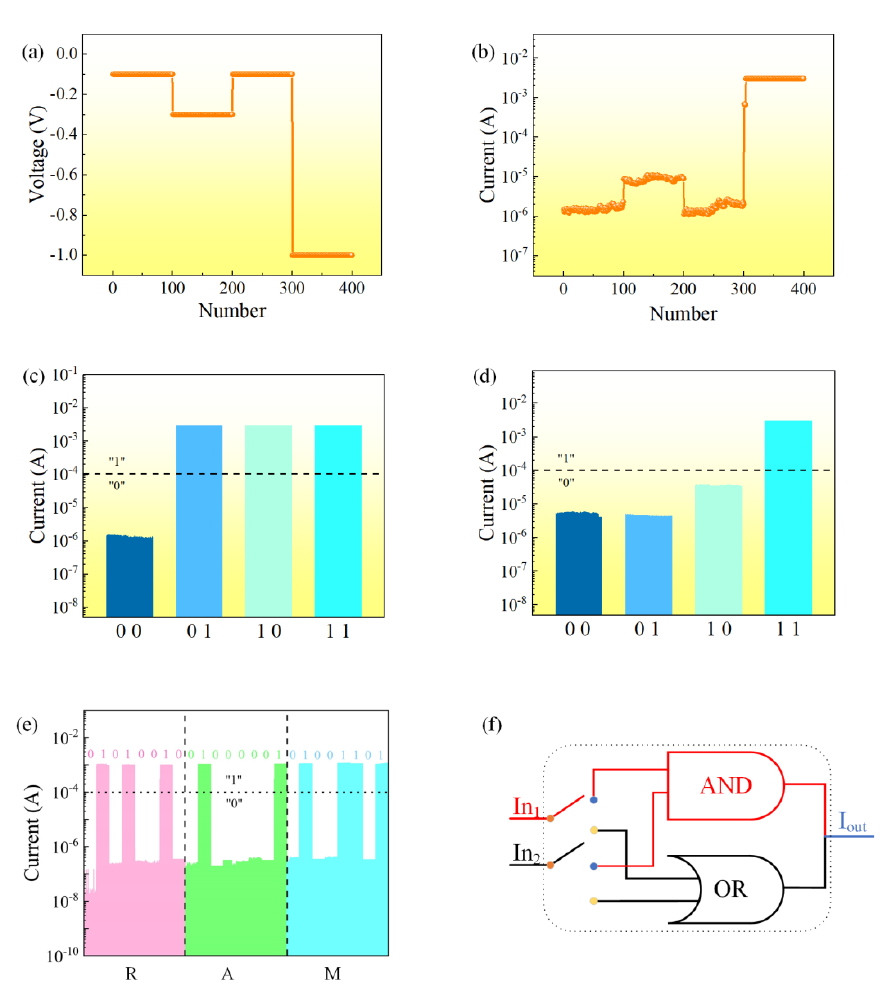
Figure 6. Al/EA:Ag + /ITO device: ( a ) input voltage and ( b ) current response. ( c ) Logic “OR gate”. ( d ) Logic “AND gate”. ( e ) Character display. ( f ) Working principle.